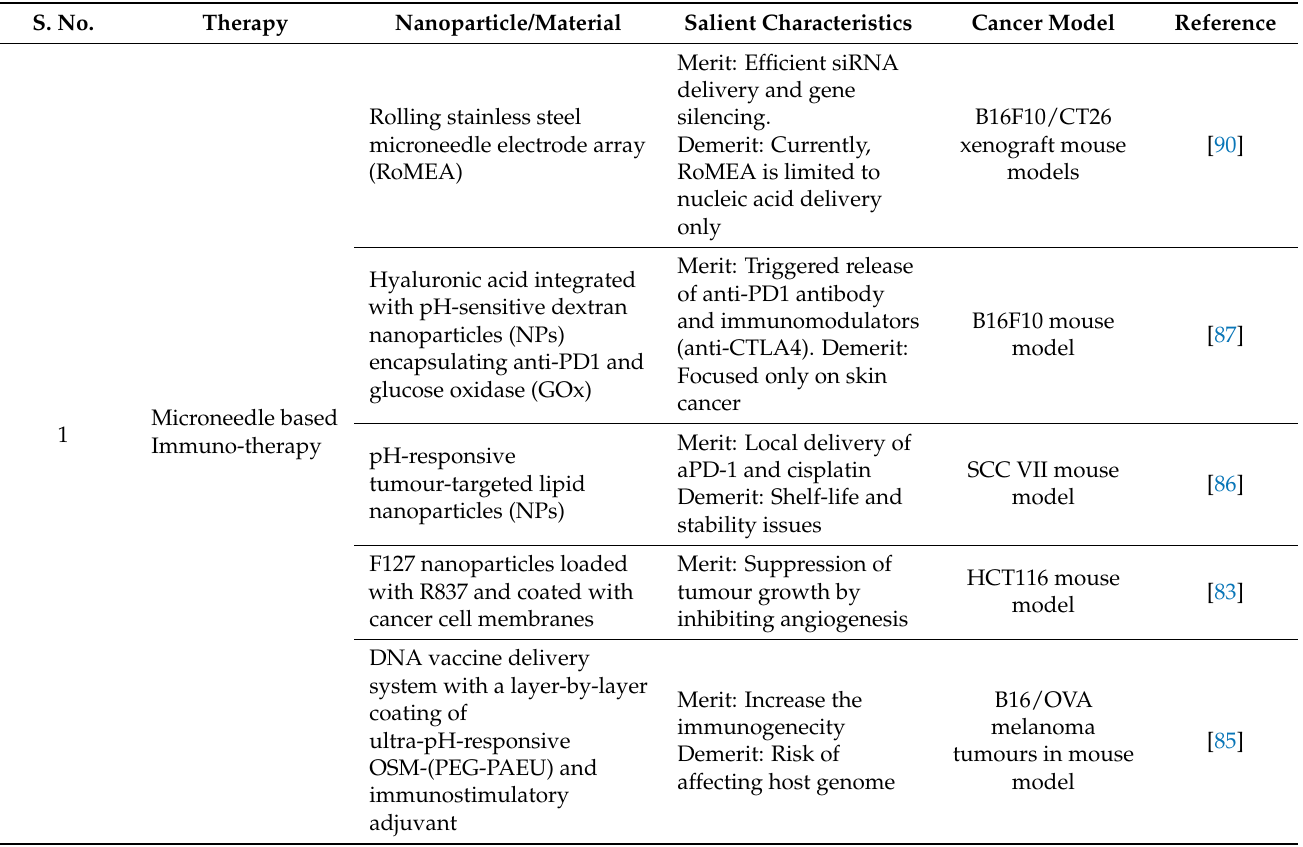
Table 2. Emerging strategies in cancer immunotherapy and their salient features. S.